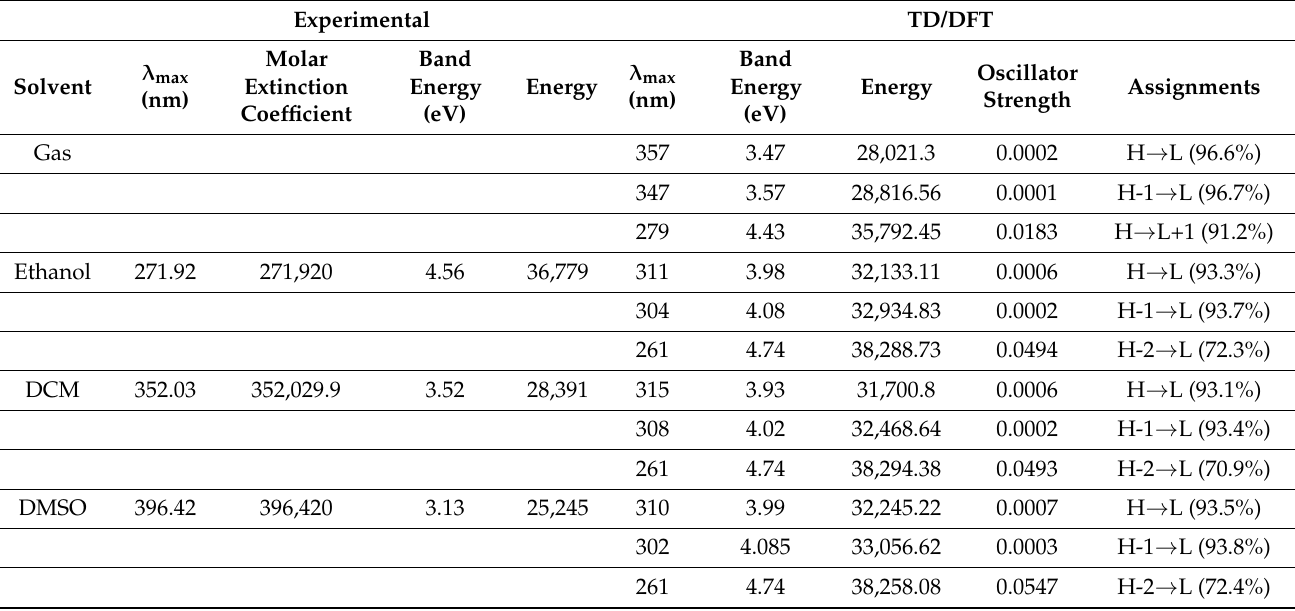
Table 5. Comparison of electronic properties of 21HBMBA attained experimentally and calculated by TD-DFT/B3LYP method.